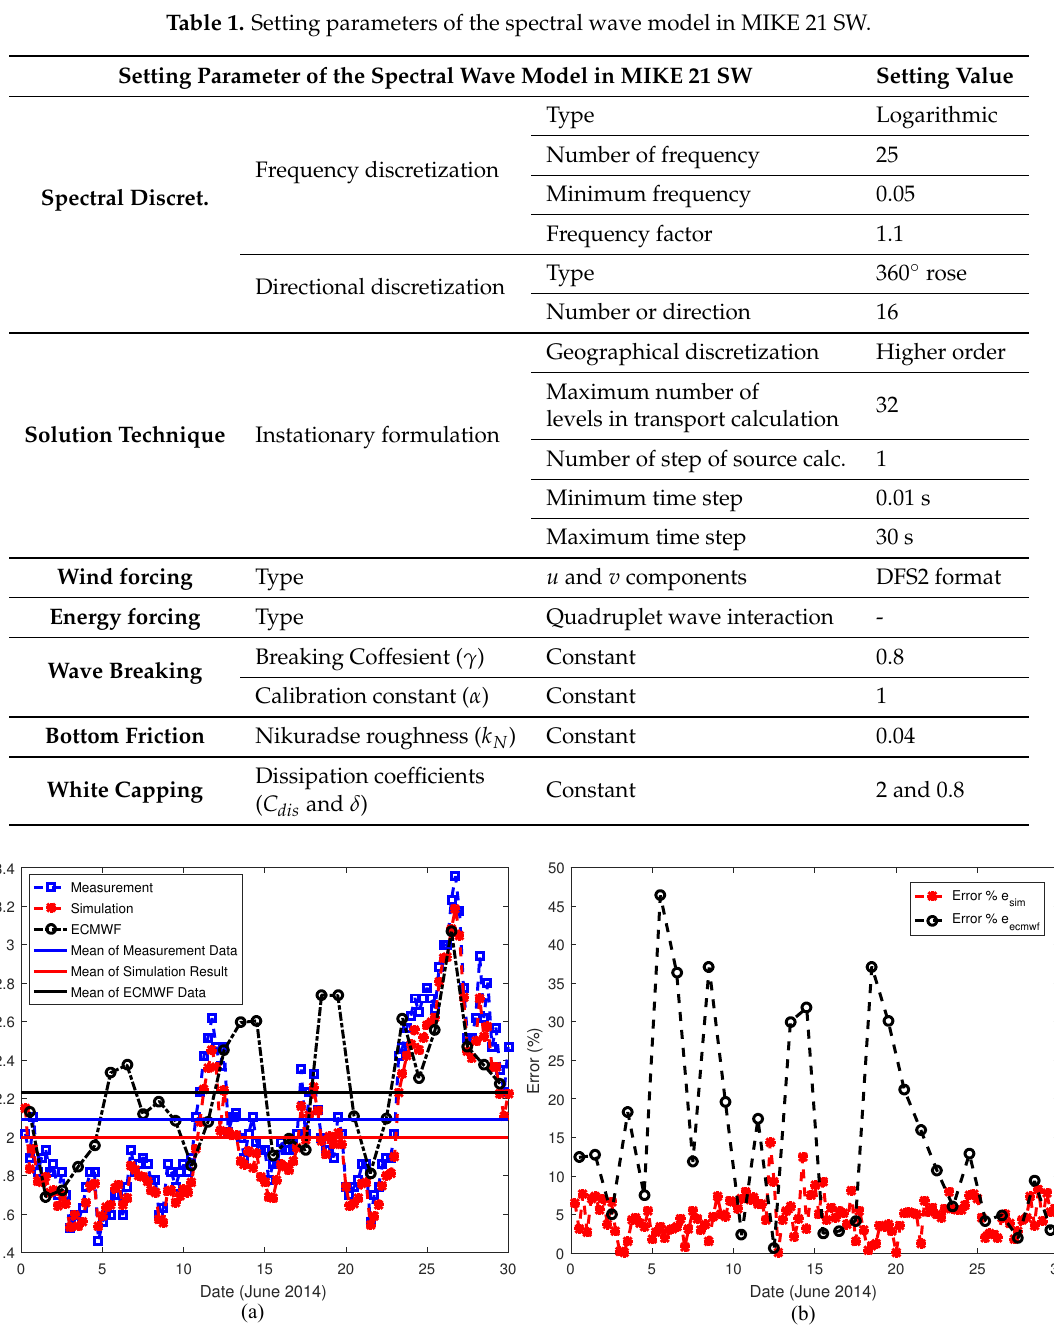
Figure 3. Observed, simulated, and European Centre for Medium-Range Weather Forecasts (ECMWF) data of significant wave height ( a ) and its percentage absolute error ( b